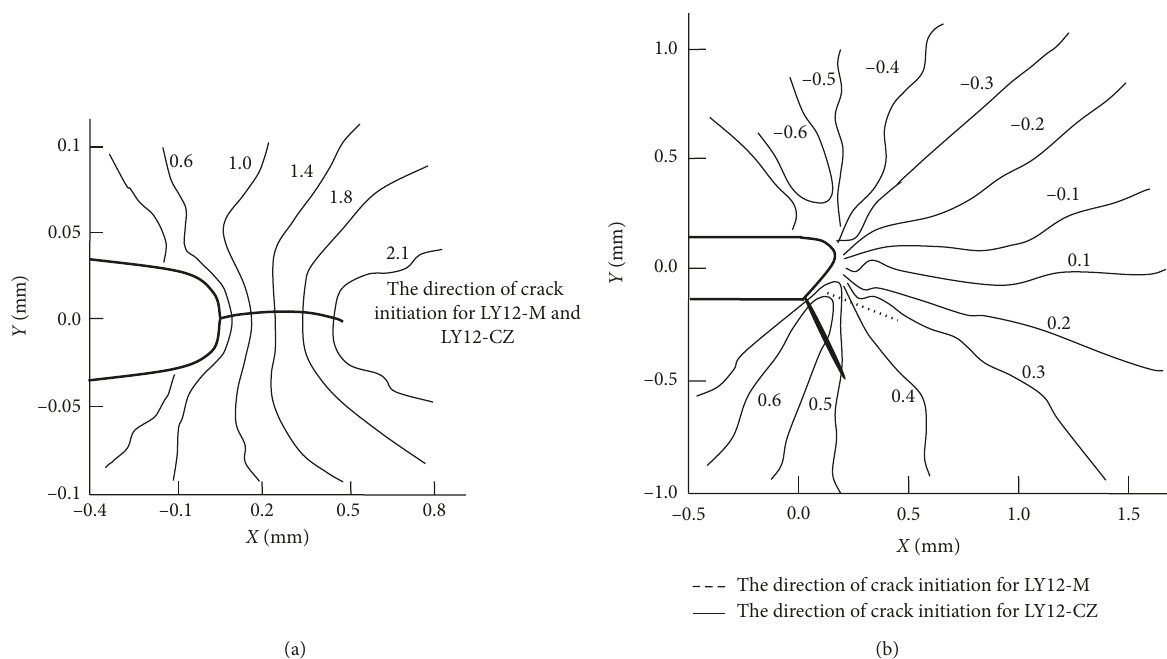
Figure 8: The schematic diagrams of relationship between the direction of crack initiation and the distribution of stress triaxiality in the loading condition of (a) mode I (b) mode